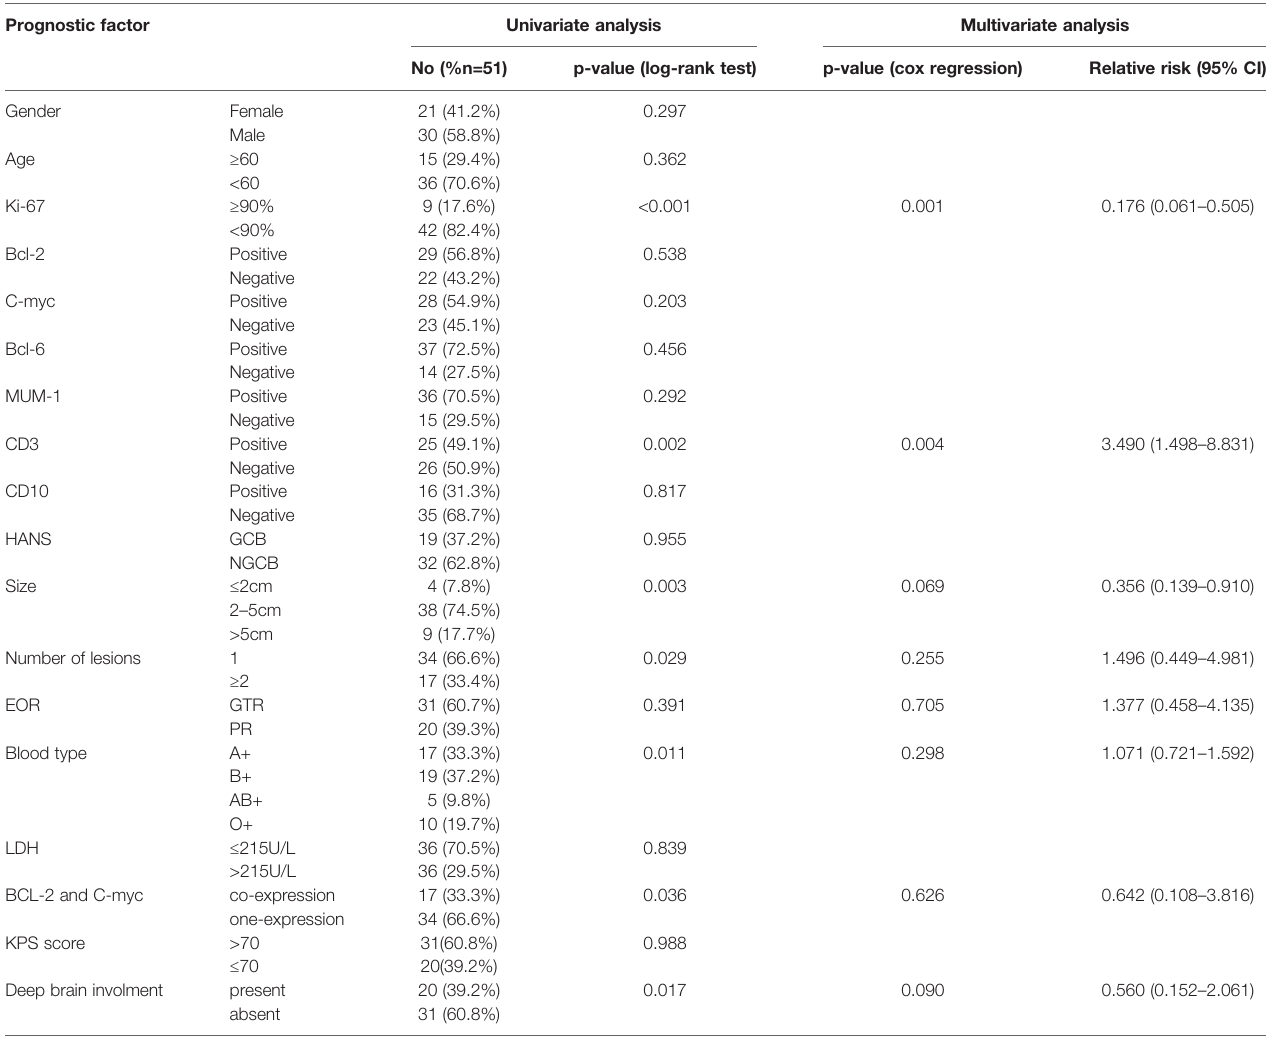
TABLE 3 | Univariate and multivariate analyses of risk factors for overall survival. Prognostic factor Univariate